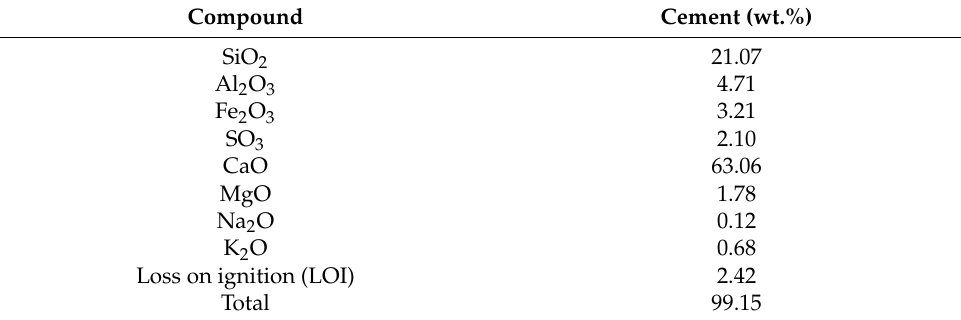
Table 2. Physical characteristics of